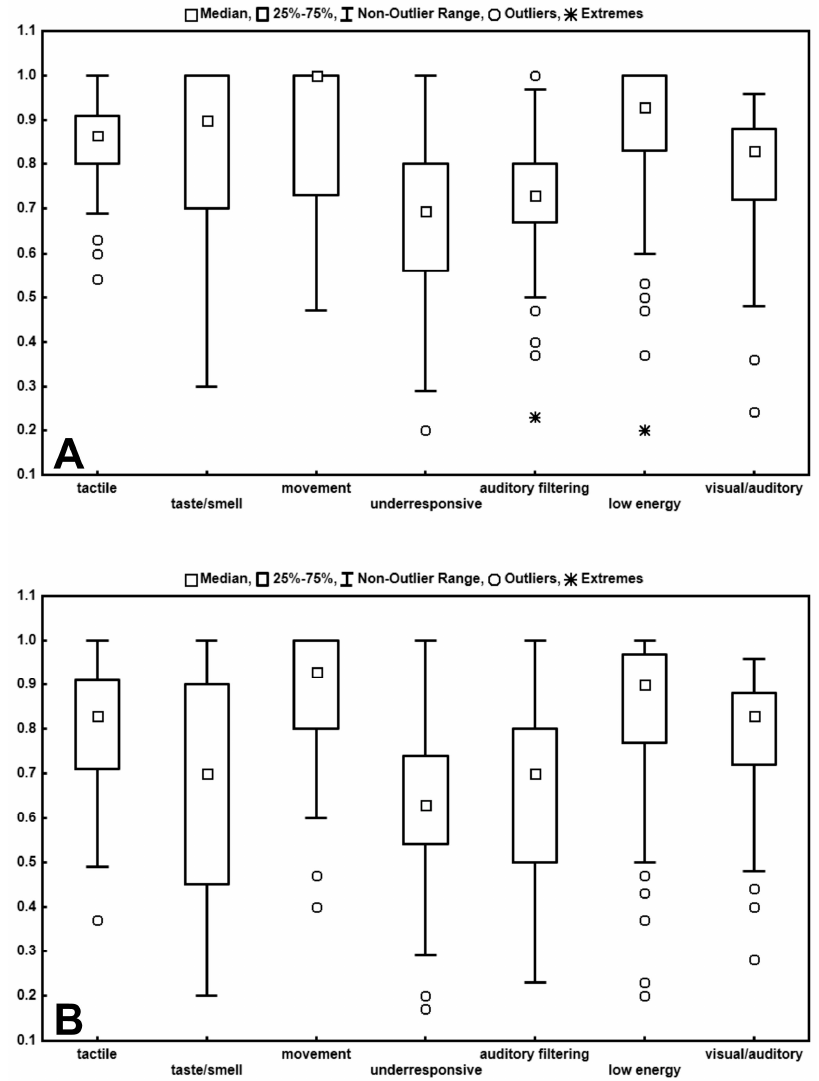
Figure 1. Scores obtained from ASD-WO ( A ) and ASD-W ( B ) in the SSP subdomains (expressed as medians of the ratios between obtained scores and maximum possible scores).